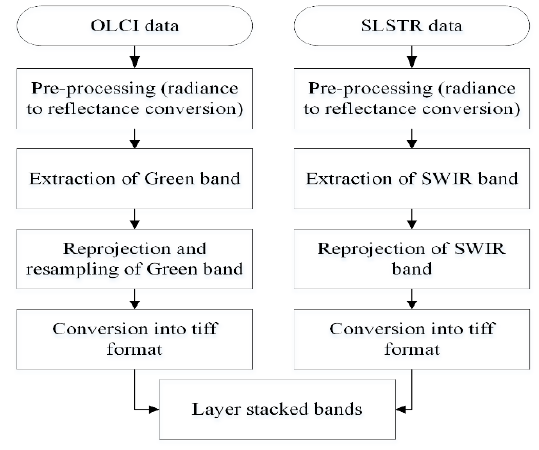
Figure 3. Flowchart for pre-processing of Sentinel-3A